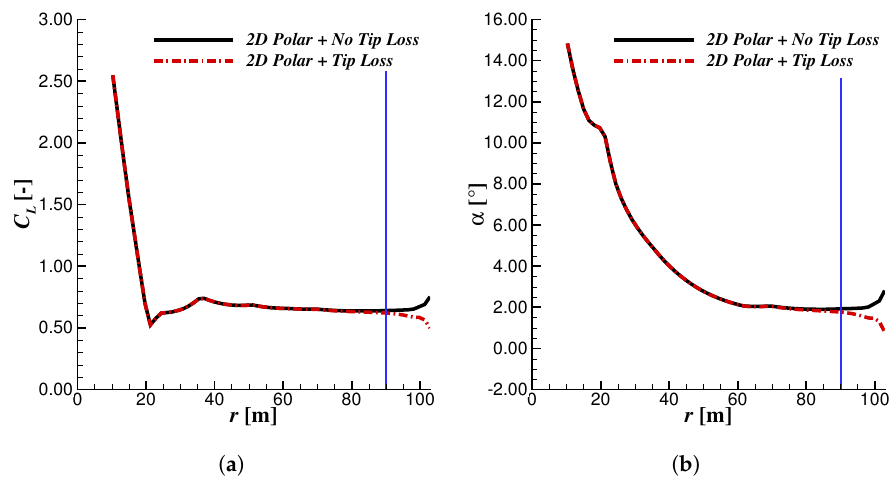
Figure 10. The effects of tip loss on the 2D polar data; ( a ) lift coefficient, ( b ) angle of attack.